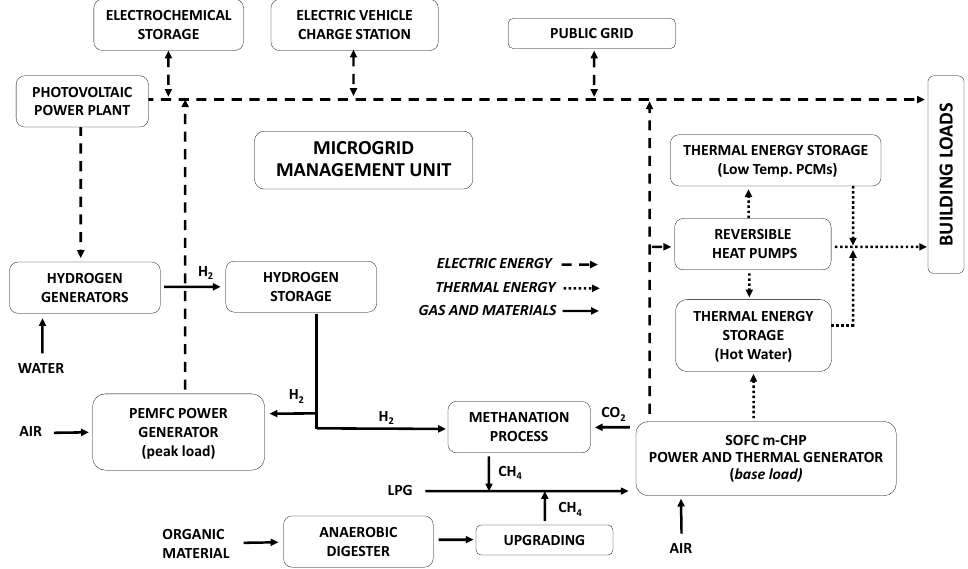
Figure 1. Schematic of the renewable energy platform microgrid.